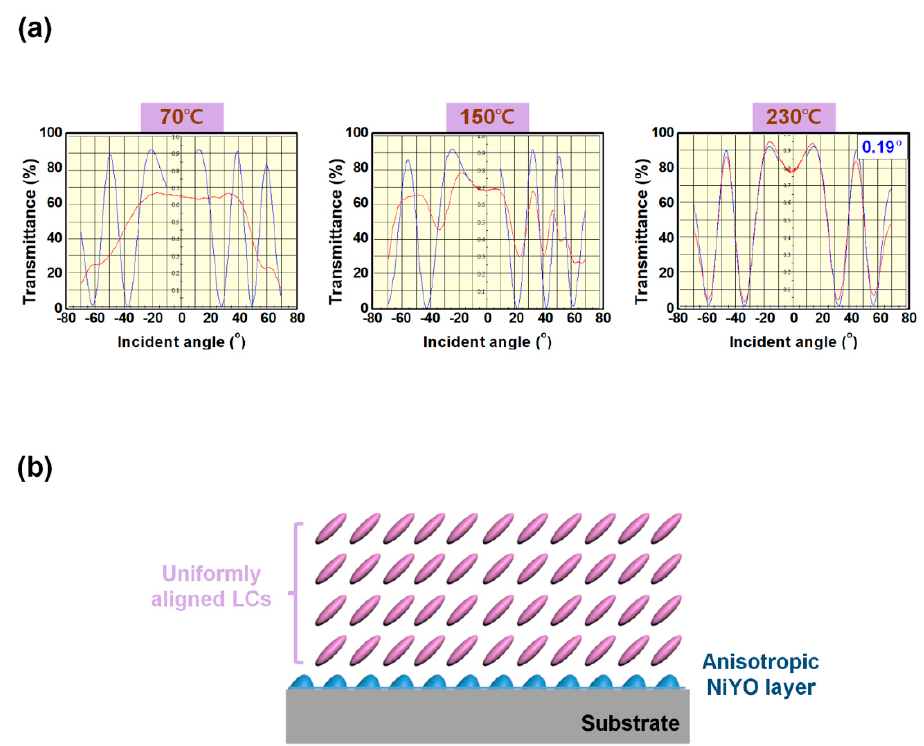
Figure 6. ( a ) Oscillated transmittance graphs measured from the anti-parallel LC cells based on the variously cured brush − coated nickel yttrium oxide films. The blue line denotes the simulation data, and the red line indicates the experimental data. ( b ) Schematic of the LC alignment on the anisotropic nickel yttrium oxide alignment layer.